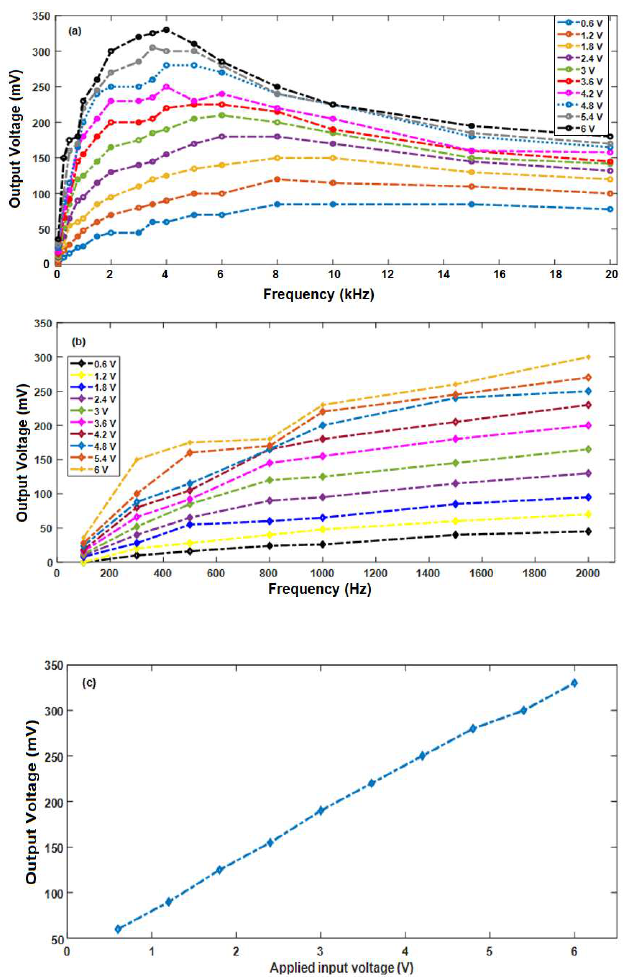
Figure 6. ( a ) Measured voltage versus frequency at different input applied voltages. ( b ) Measured voltage versus low frequency (up to 2 kHz) at different input applied voltages. ( c ) The output voltage versus applied input voltage at a frequency of 4 kHz.